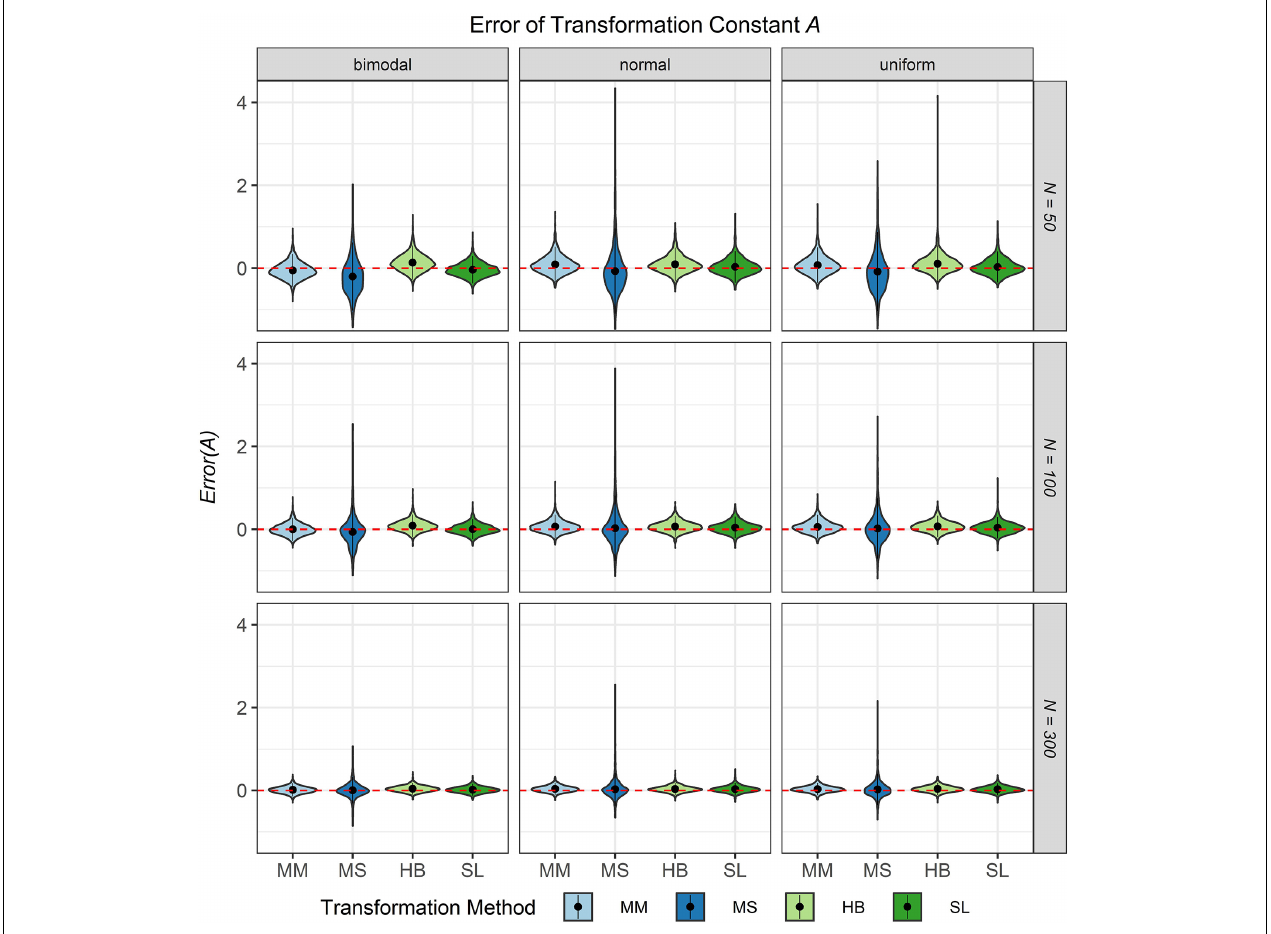
FIGURE 8 | Error of the transformation constant A in the continuous calibration strategy for different sample sizes per test cycle, different common item difficulty distributions, and different scale transformation methods (MM = Mean/Mean, MS = Mean/Sigma, HB = Haebara, SL = Stocking-Lord). The dot in the middle of each violin represents the bias and the width of the violin expresses the frequency of the corresponding